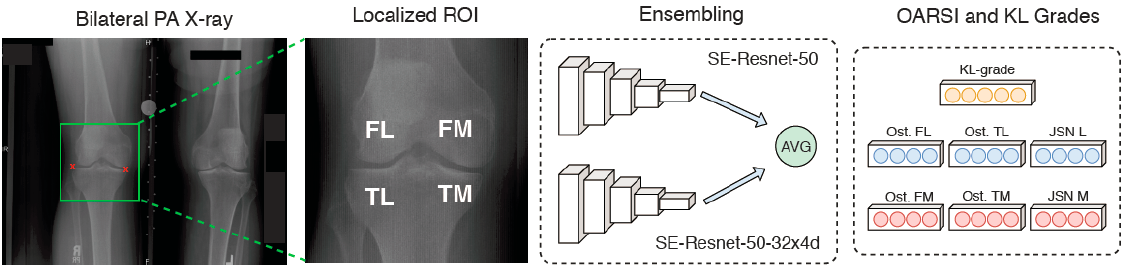
Figure 13. Schematic representation of the workflow of [87] approach.